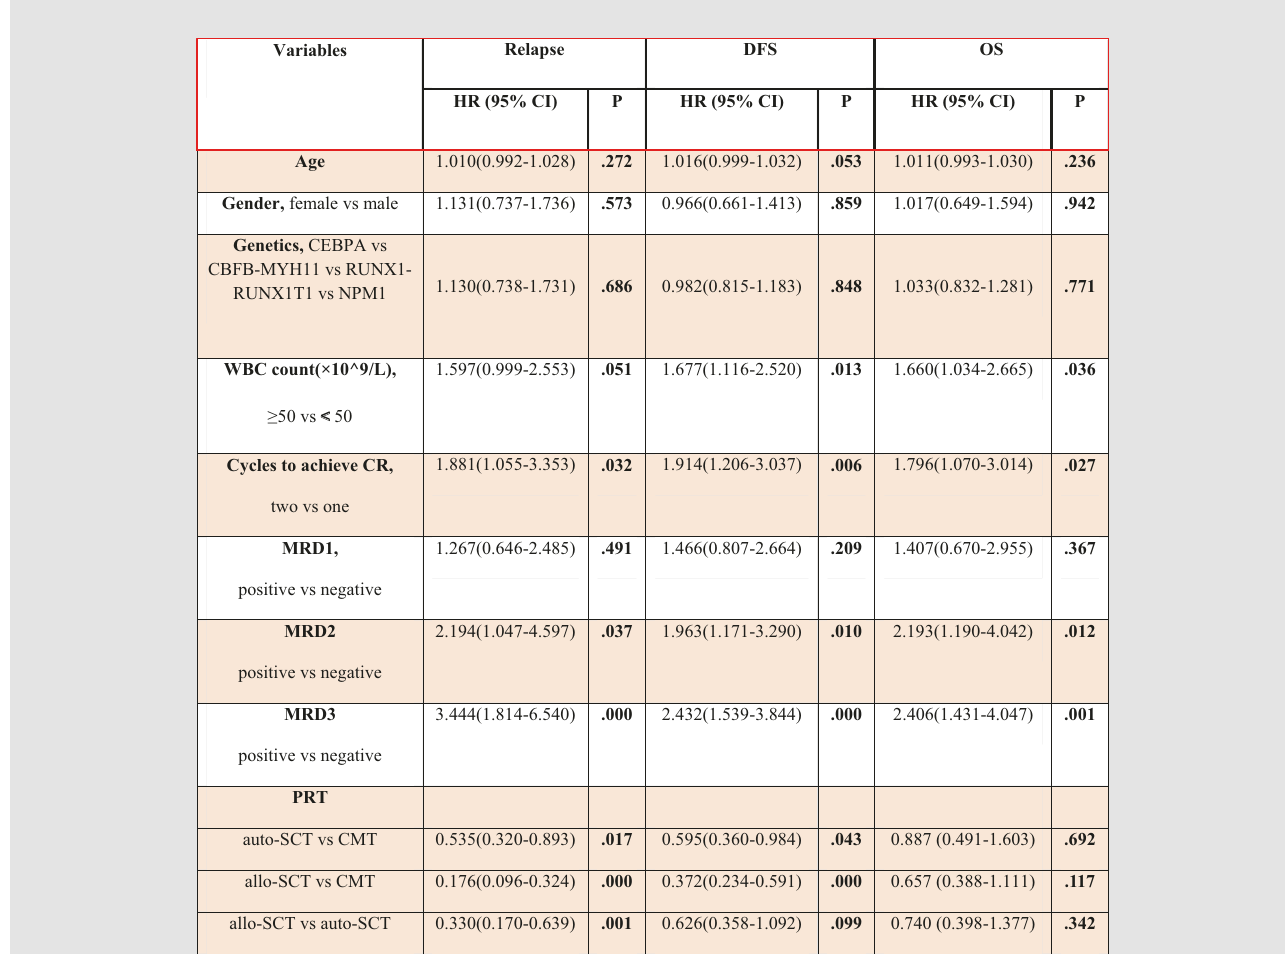
Variables Relapse